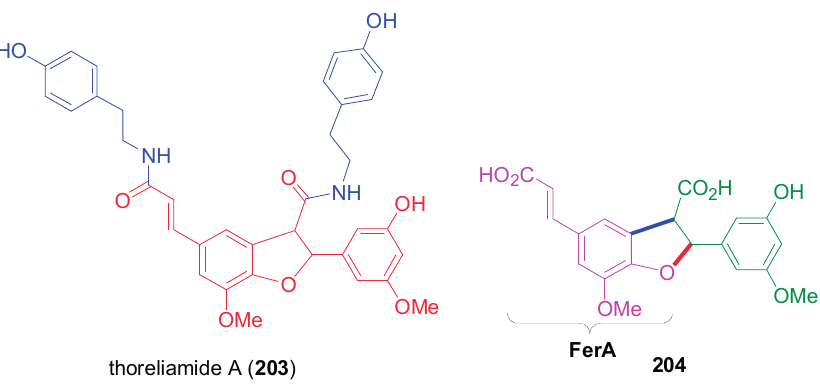
Figure 12. The structure of thorielamide A ( 203